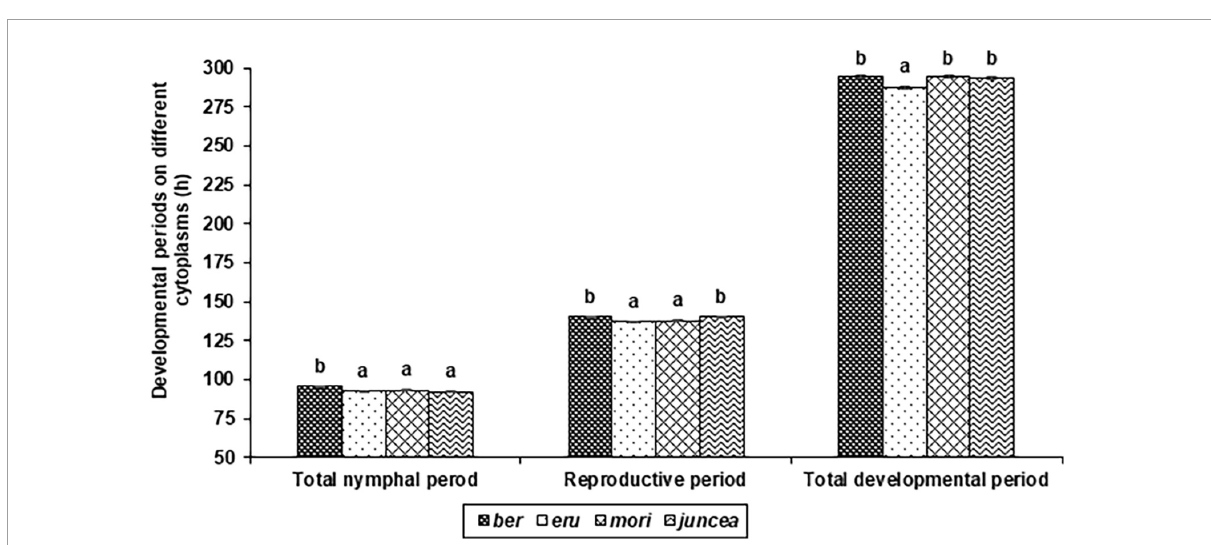
FIGURE2 Effects of cytoplasms on developmental and reproductive periods of Lipaphis erysimi in Brassica